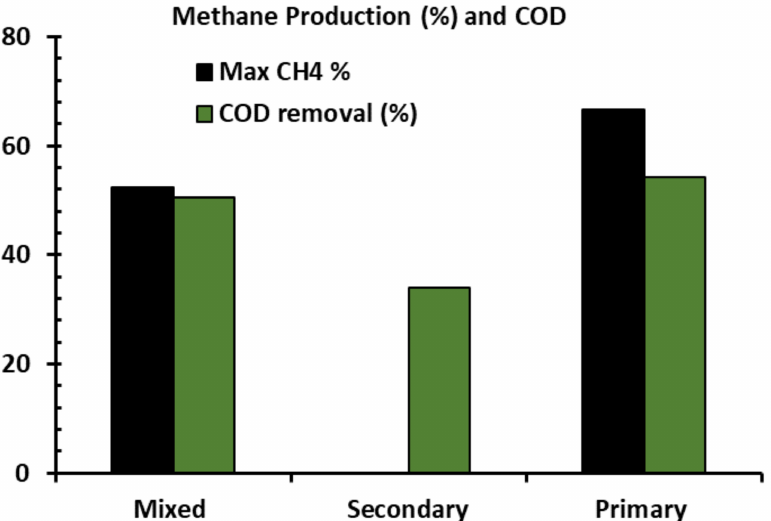
Figure 4. Relation of COD removal and the methane production in the different